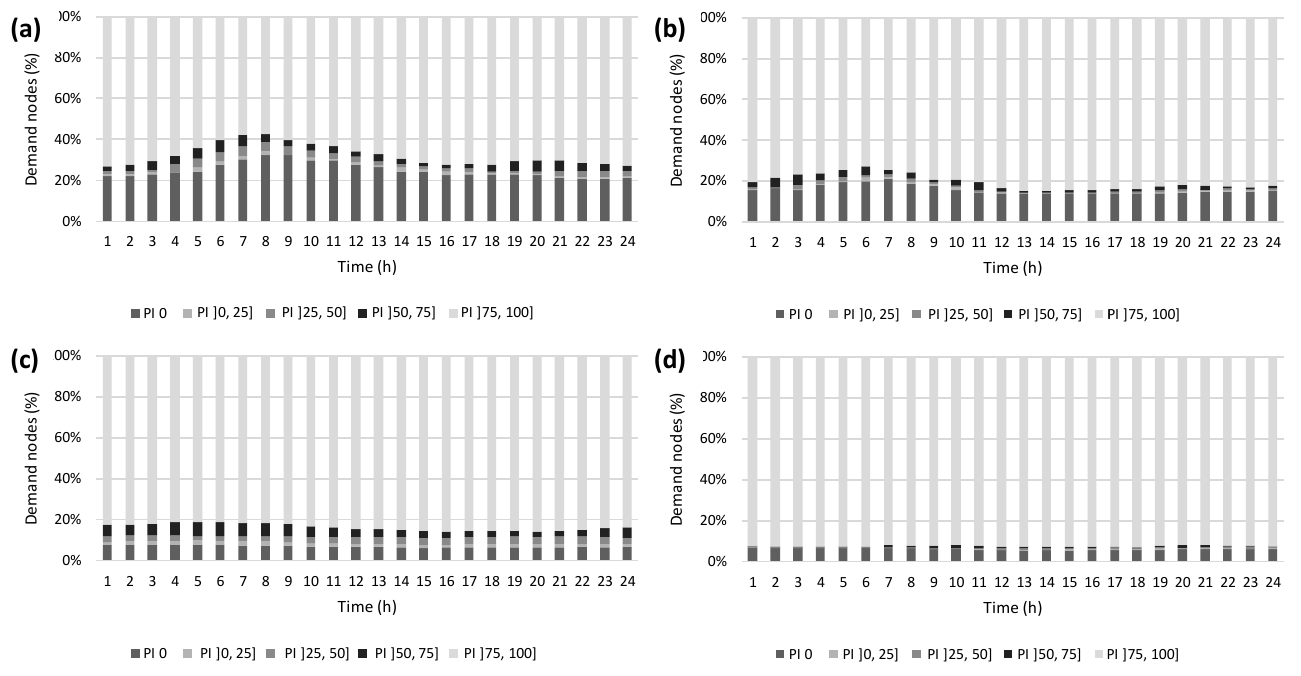
Figure 11. Performance index at the consumption nodes over a 24 h period in ( a ) Case Study 1 in winter, ( b ) Case Study 1 in summer, ( c ) Case Study 2 in winter, and ( d ) Case Study 2 in summer. Table 1. Global performance index obtained using the proposed functions and those from the literature. Mean